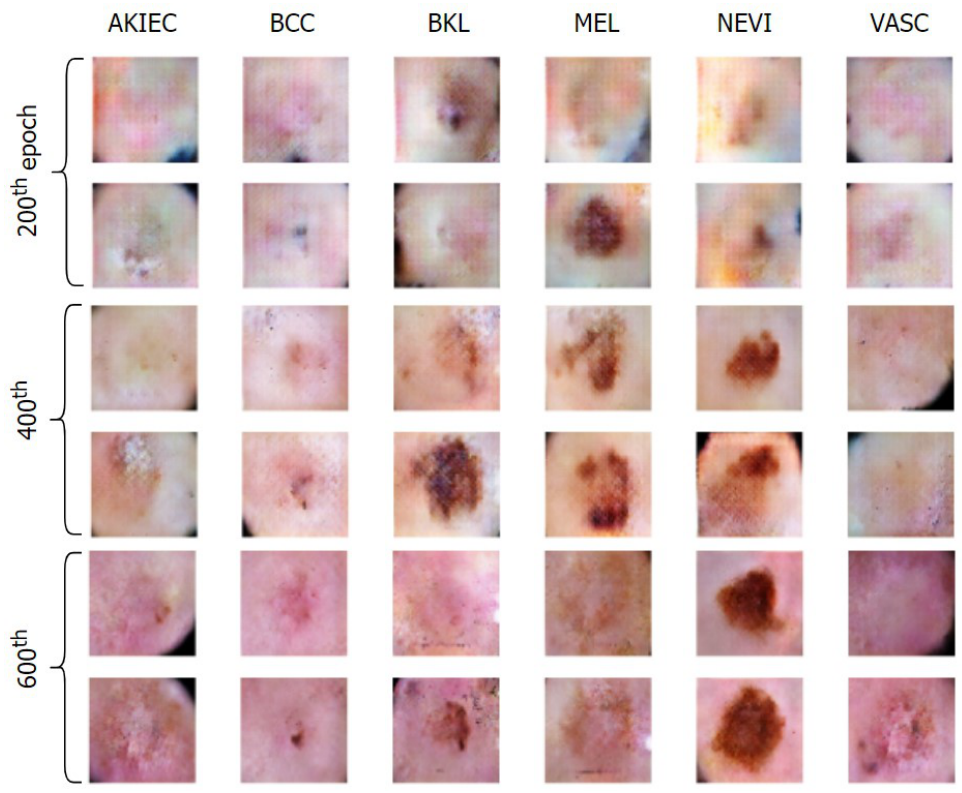
Figure 8. Generation of conditional skin lesions associated in each category at the initial 600 epochs.